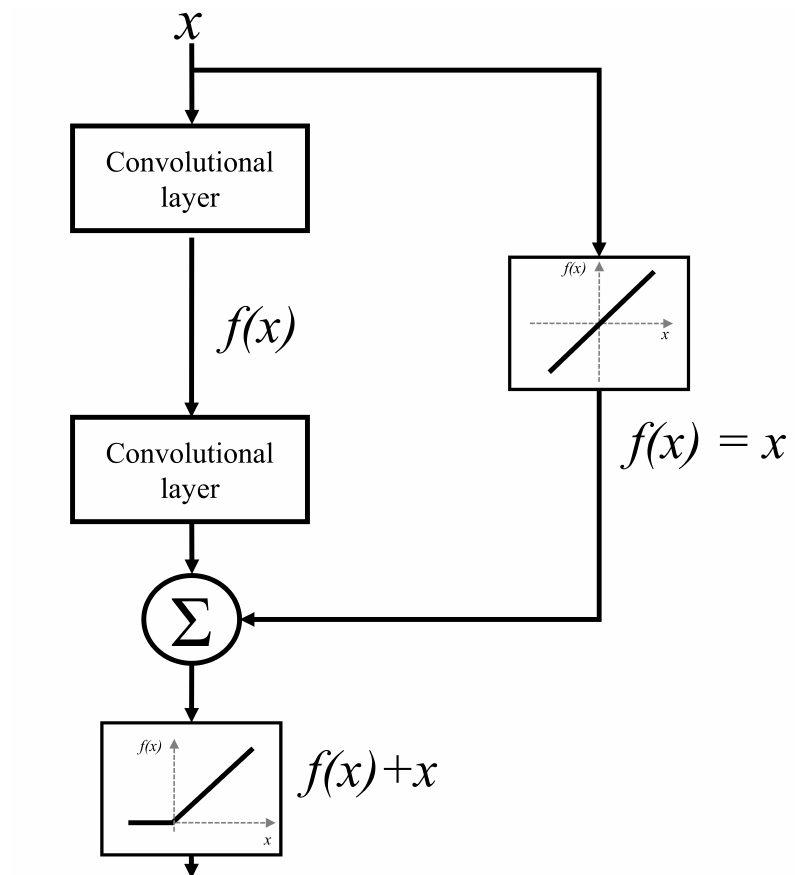
Figure 9. A block scheme of an Inception-residual block.